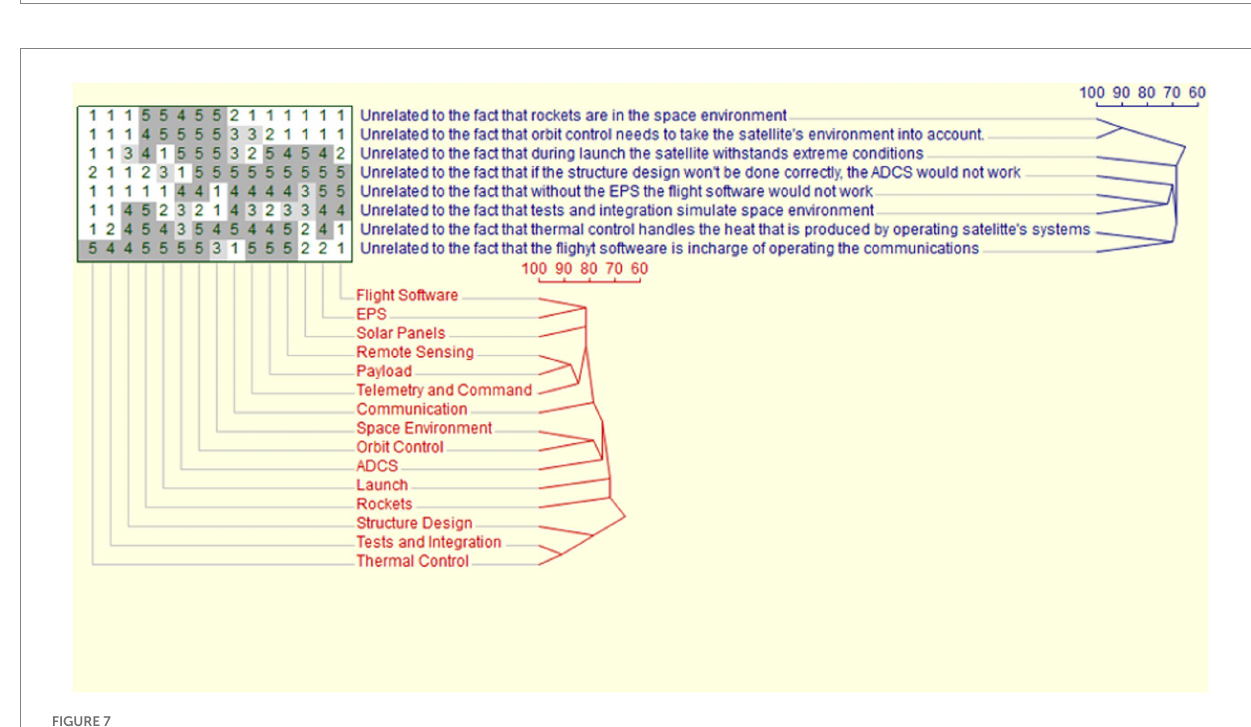
FIGURE 6 Andy’s first repertory grid.